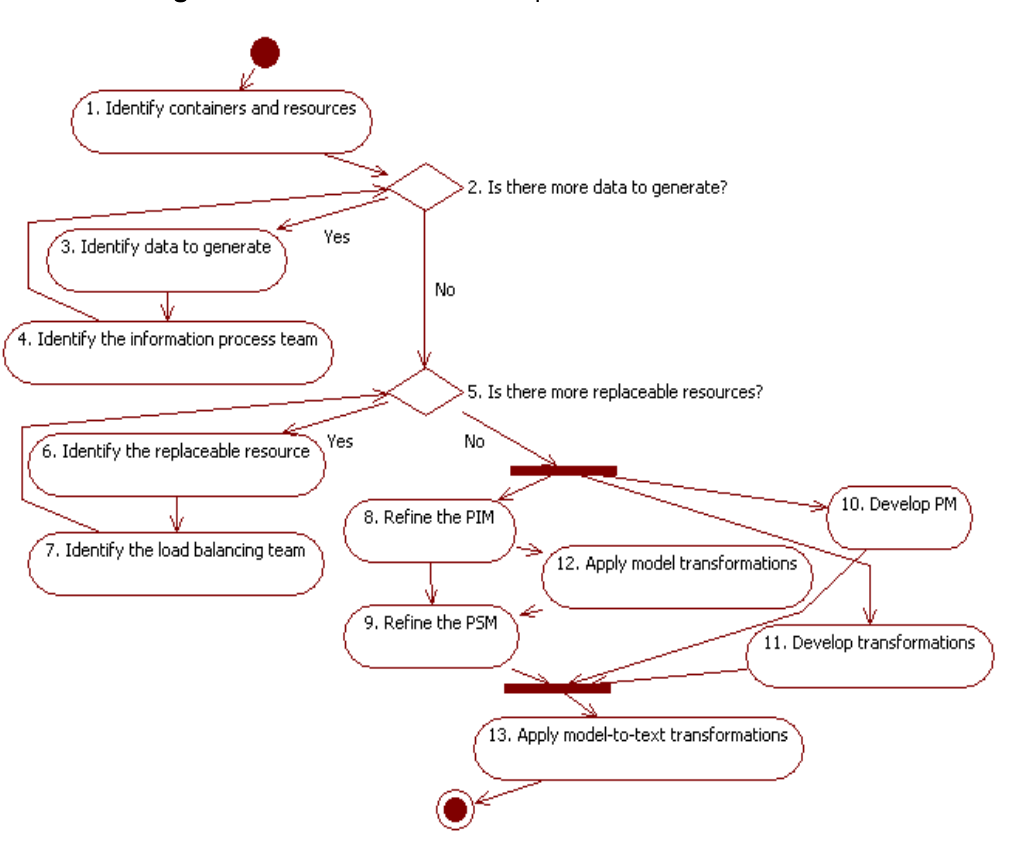
Figure 2. Process for the development of sensor